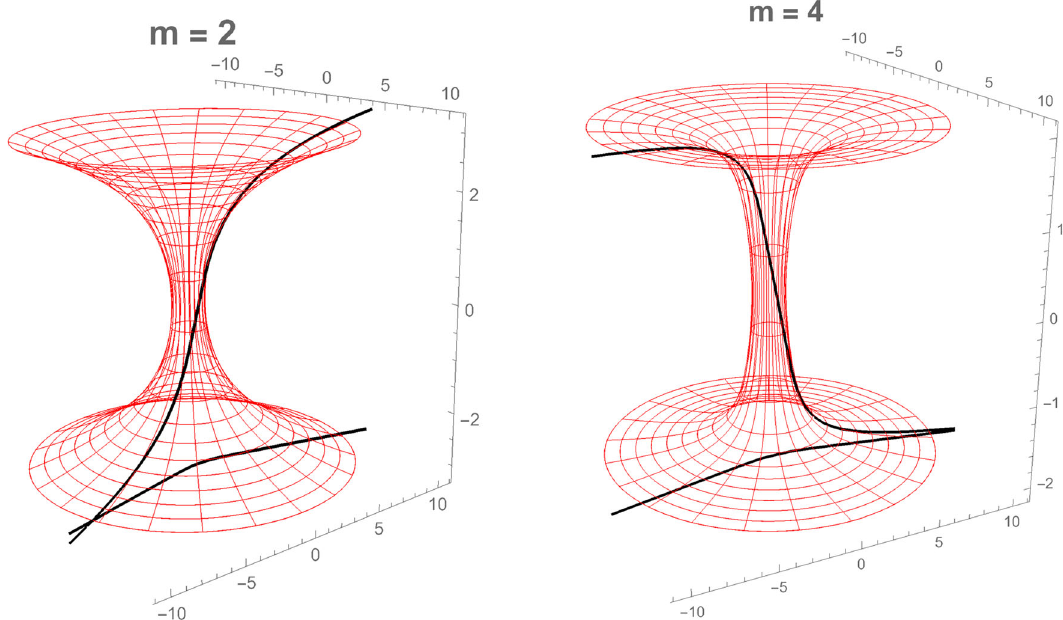
Fig. 8 Crossing geodesics in m = 2 and m = 4 4D-GEB geometries